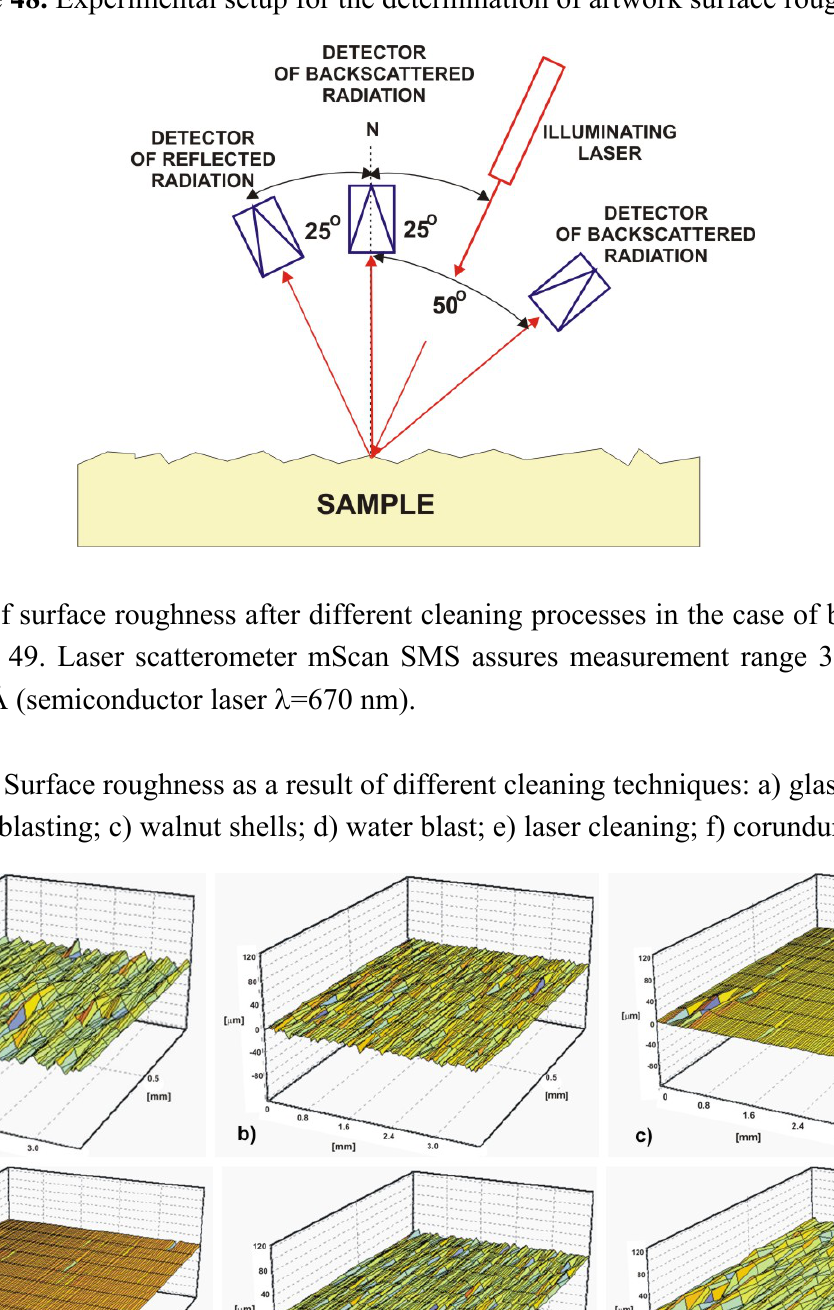
Figure 48. Experimental setup for the determination of artwork surface roughness.